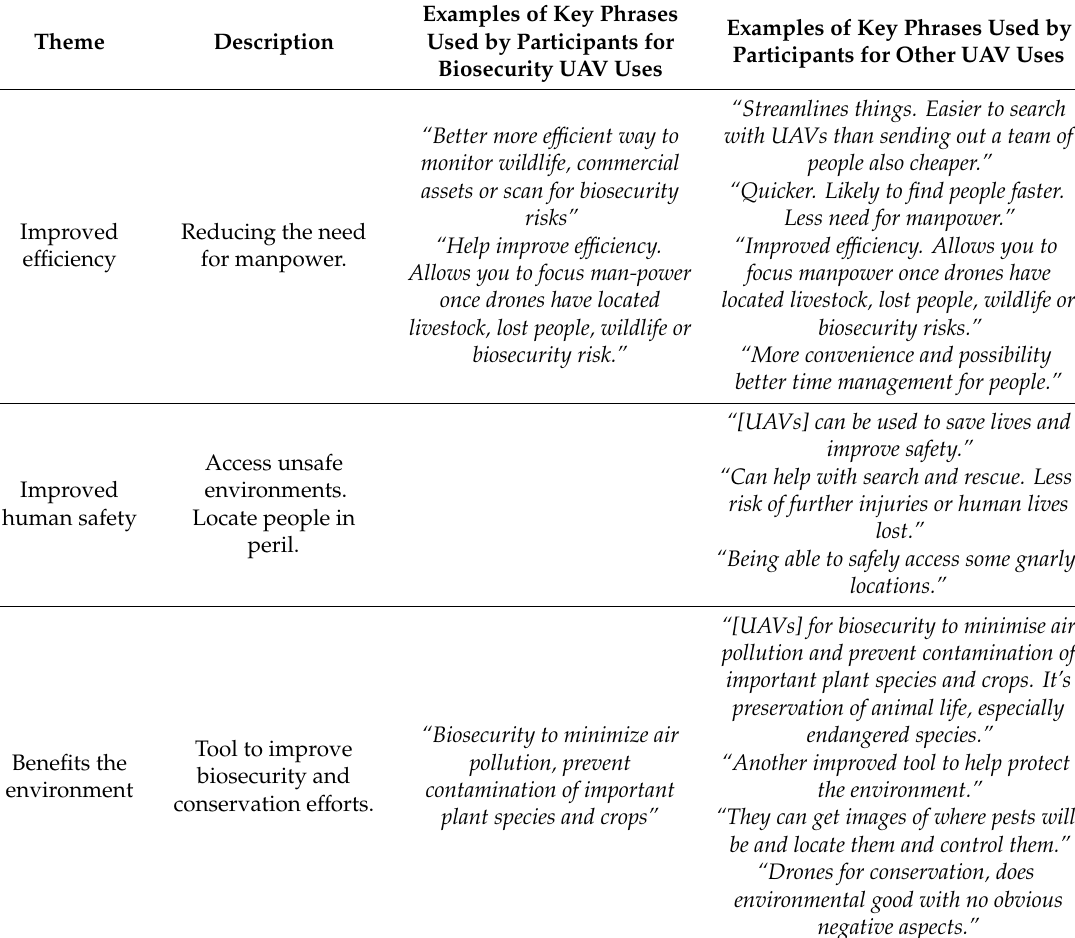
Table 2. Examples of key phrases used to describe the five most prominent themes associated with people’s perception of the positive aspects of UAVs, both for biosecurity-specific uses and for the other 12 use categories that were